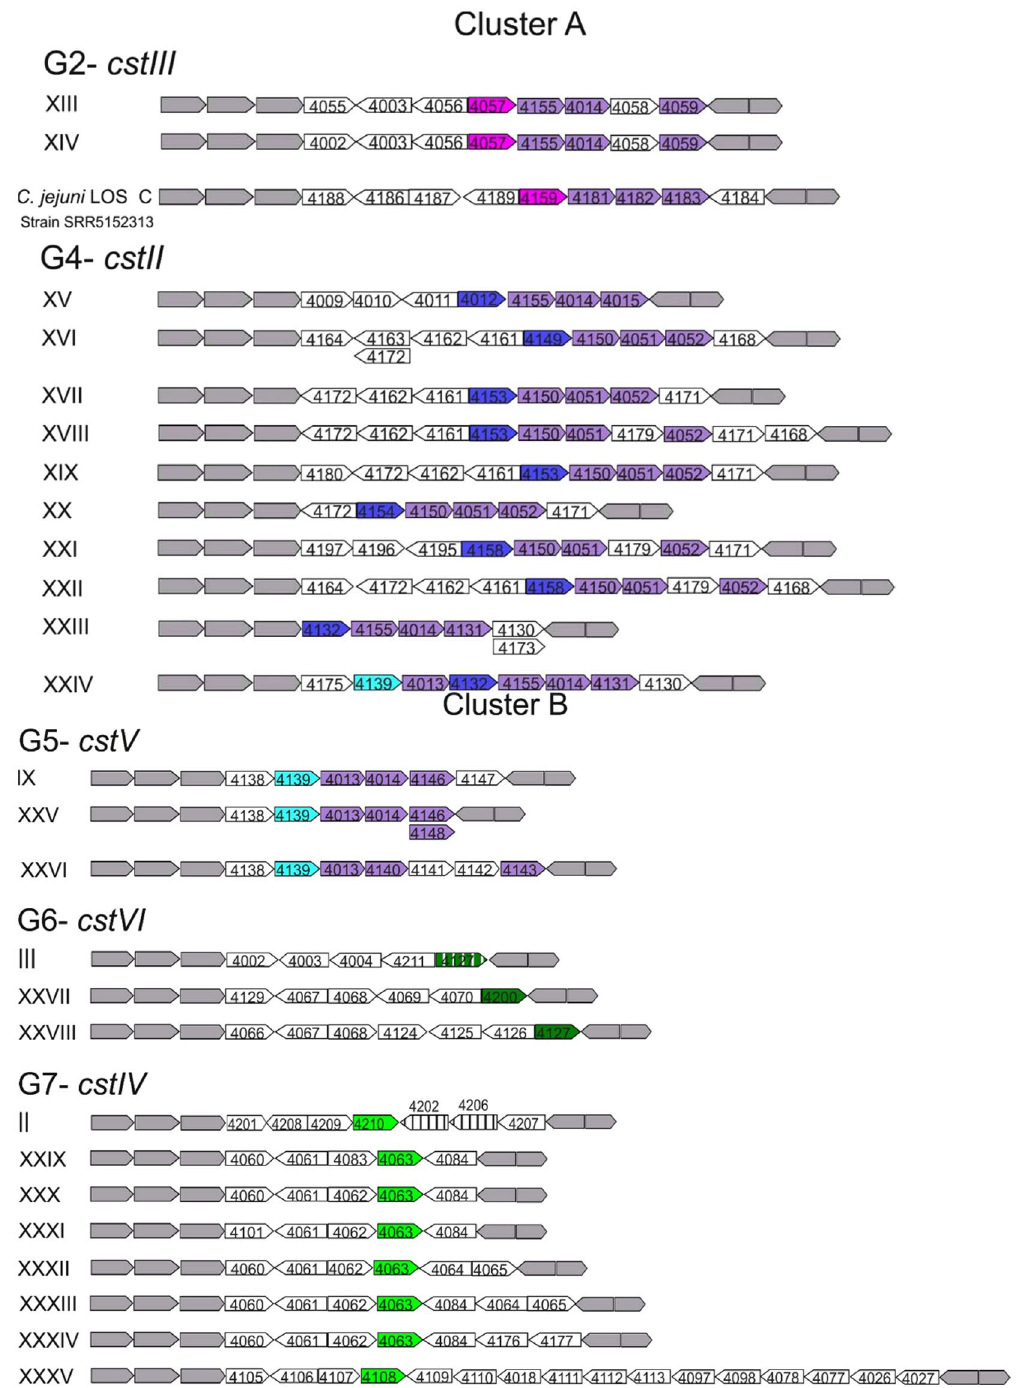
Figure 2. C . coli LOS classes containing GT-42 genes. Arrows represent open reading frames. White arrows: genes putatively unrelated to biosynthesis and transfer of Neu5Ac. Grey arrows: conserved genes. Purple arrows: sialic acid biosynthesis genes always present neuB , neuC , and neuA order. Pink arrows: GT-42 orthologues from group 2. Dark blue arrows: GT-42 orthologues from group 4. Light blue arrows: GT-42 orthologues from group 5. Dark green arrows: GT-42 orthologues from group 6. Light green arrows: GT-42 orthologues from group 7. Striped genes are fragmented. Representation of LOS class II was adapted to reflect origin from LOS class XXXIV. Gene size is not drawn to